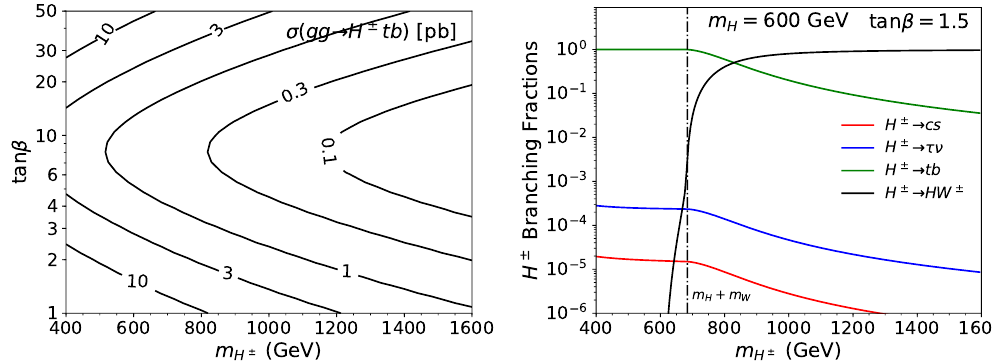
Figure 1 . The left panel shows the charged Higgs production cross section of gg → H ± tb in the m vs. tan β plane for a 100 TeV pp collider. The right panel shows the branching fractions H ± of charged Higgses for H ± → cs (red), τν (blue), tb (green), and HW ± (black) at tan β = 1 . 5 , m H = 600 GeV. The dash-dotted lines indicates the mass threshold at m H + m W . The decay branching fractions of H ± as a function of their mass are shown in the right panel of figure 1 for m = 600 GeV and tan β = 1 . 5 . For m H dominates, with H ± → τν, cs being almost negligible. However, once m H ± → HW ± quickly dominates, as shown by the black curve. All branching fractions are calculated using 2HDMC